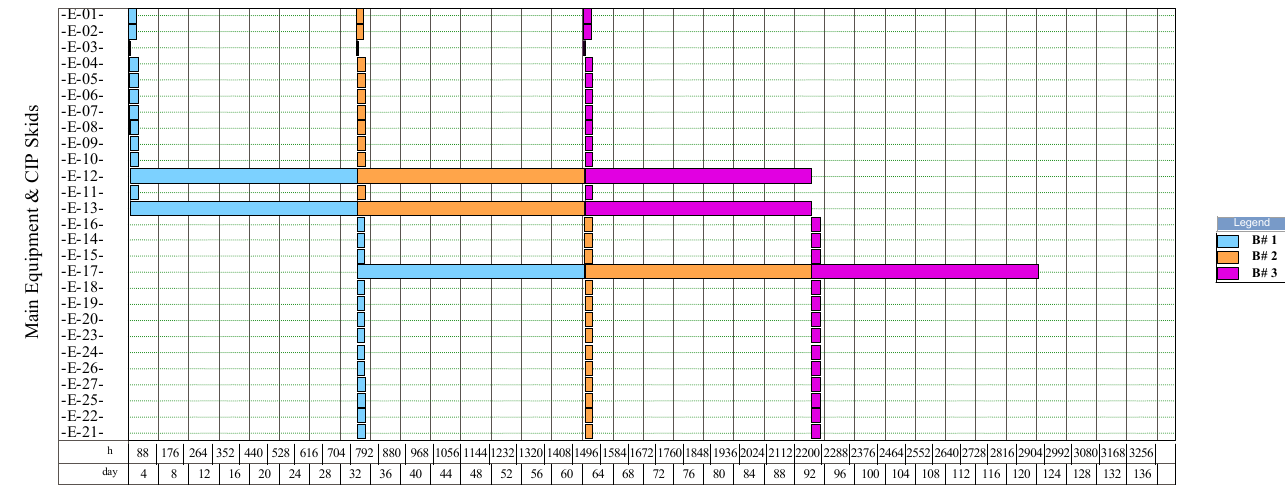
Figure 10. Equipment occupancy chart of the process for producing natural fibers from pseudostems. B: batch ; CIP: cleaning-in-place . The labels of the equipment units are shown in Figure 6.